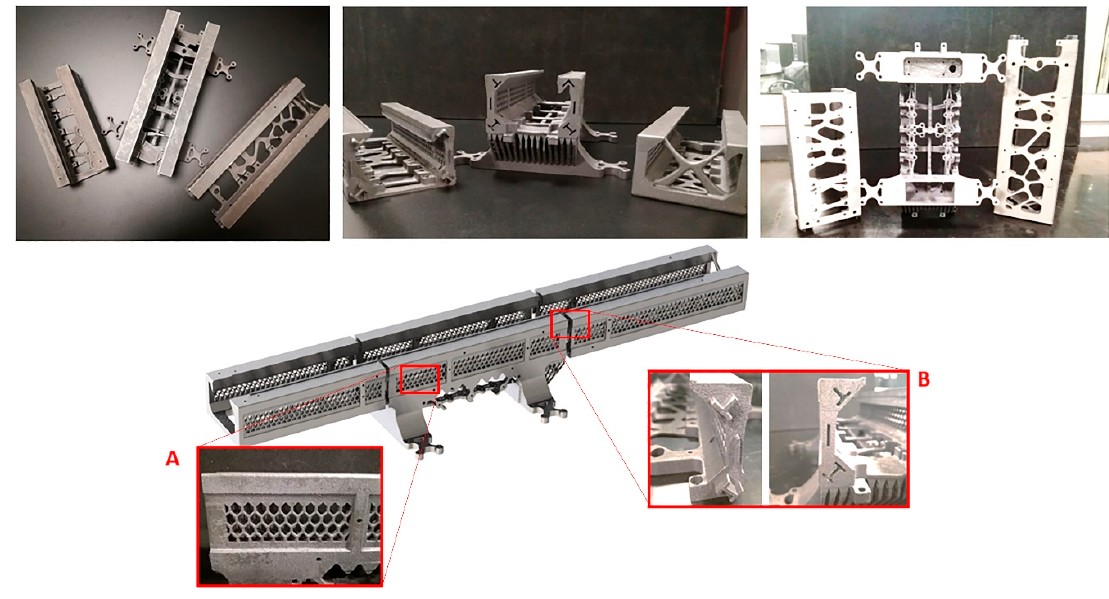
Figure 8. Technical prototype with details of the walls of the X-rail ( A ) and the shaft-hub interference fit ( B ). fit ( B